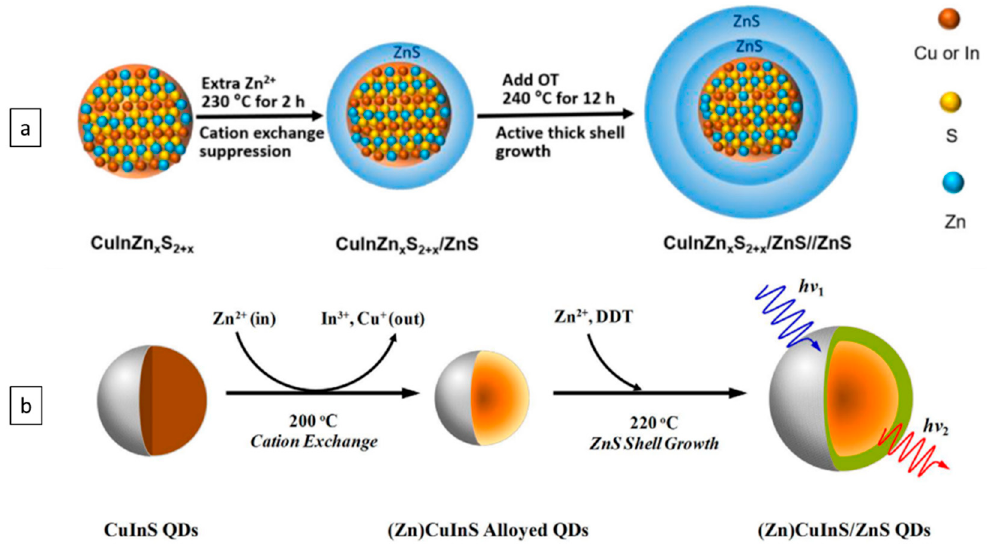
Figure 8. Scheme of ( a ) CIZS/ZnS/ZnS heterostructure. Reproduced with permission from [159].